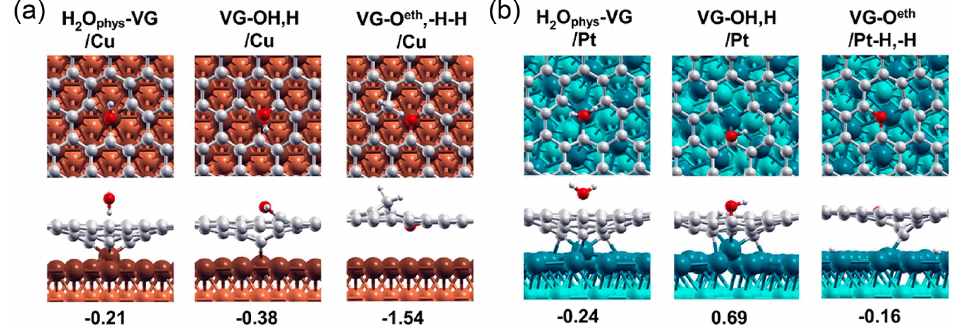
Figure 9. The calculated dissociation paths of a H 2 O molecule on ( a ) defective-Gr/Cu and ( b ) defective-Gr/Pt surfaces, where three key steps are presented by the top and side structural views. Adapted with permission from Reference [143]. Copyright 2017, American Chemical